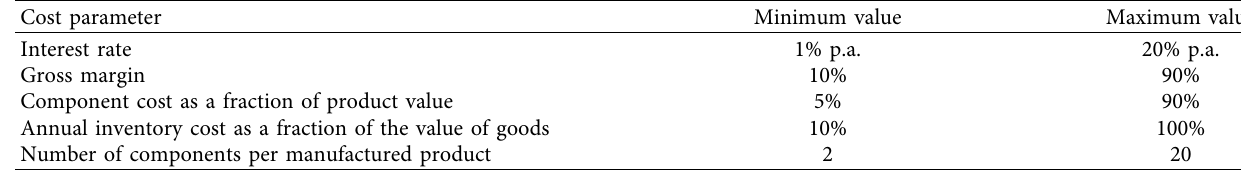
Table 3: Range of values used to determine the sensitivity of TEC w.r.t. cost parameters.